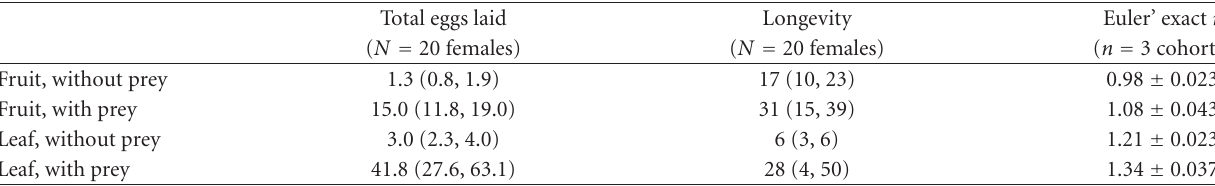
Table 1: Mean (upper and lower 95% CL) total eggs laid, lifetime (upper and lower 95% CL) and mean ± SEM, Euler’s exact r for female D. hesperus on either tomato leaf or tomato fruit, with or without prey (eggs of E. kuhniella ). N = 20. Total eggs laid Longevity Fruit, without prey Fruit, with